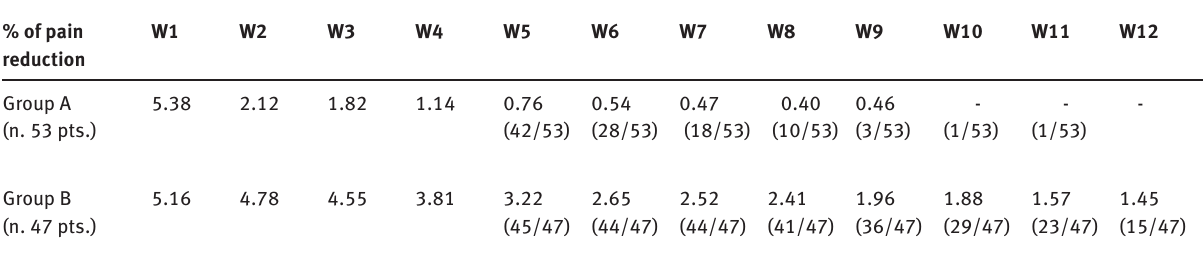
p-value for com-